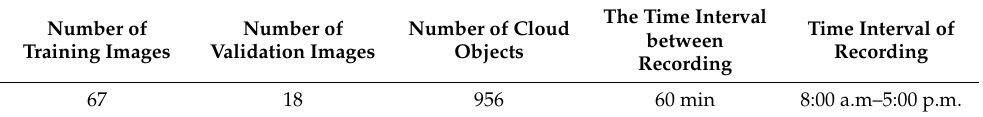
Table 2. Overview of the collected image data set.